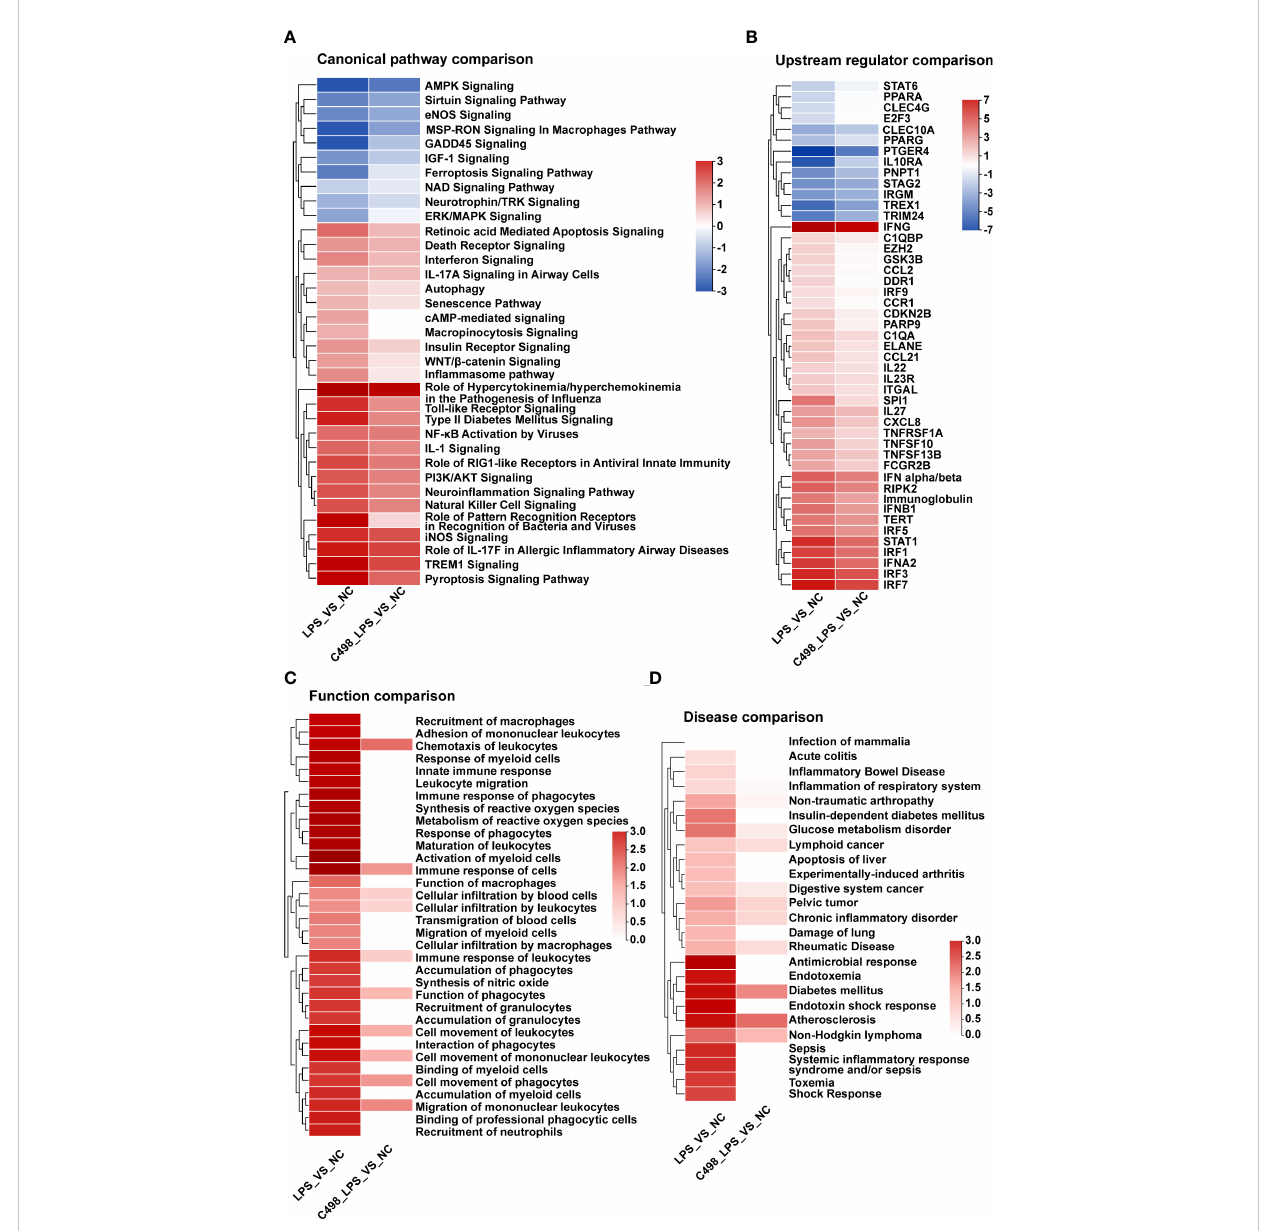
FIGURE 4 Comparative analysis of C498 anti-in fl ammatory ef fi ciency. (A-D) , Canonical Pathway Comparison (A) , Upstream Regulator Comparison (B) , Biological Function Comparison (C) , and Disease Comparison (D) were conducted by comparing the signi fi cant differences between (C498_LPS vs NC) and (LPS vs NC). Positive z scores indicate an increase whereas negative ones indicate a reduction in speci fi c